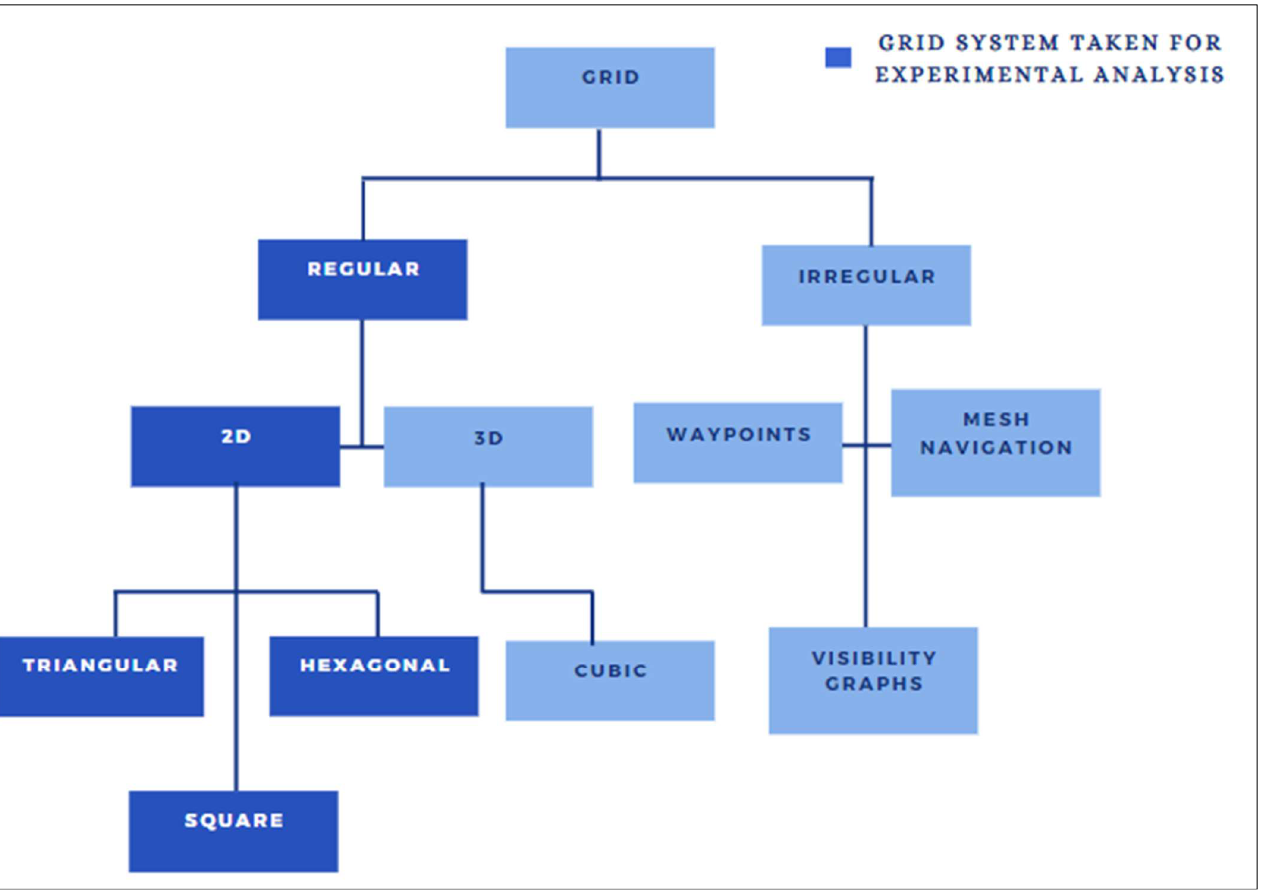
Figure 2. Hierarchical classification for pathfinding using grids.